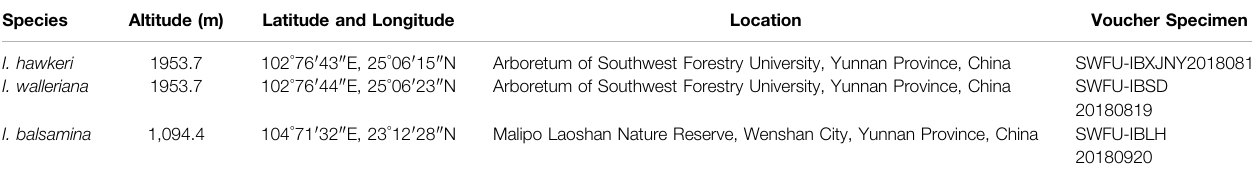
TABLE 1 | The list of basic information of Impatiens species sequenced in this study. Species Altitude